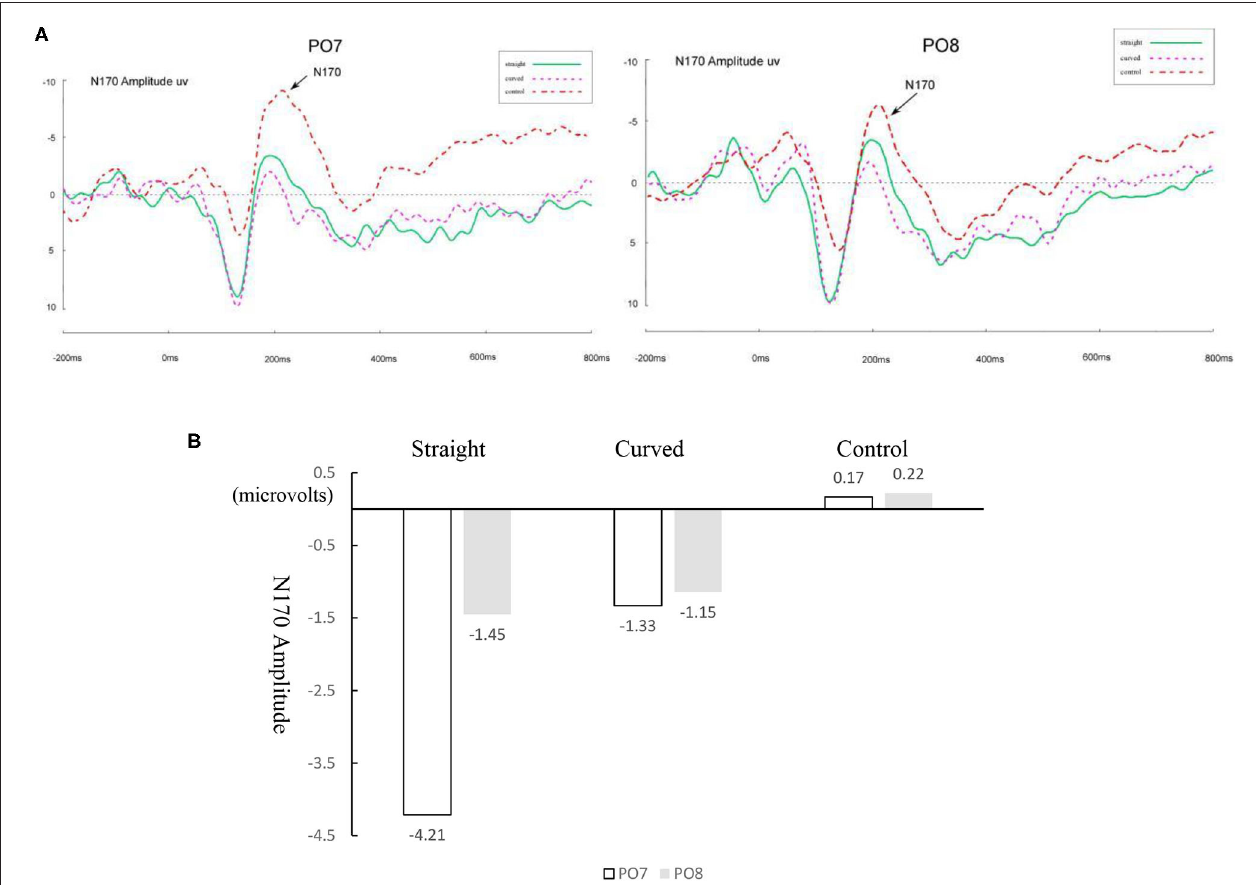
FIGURE 7 | (A) ERP waveforms of N170 under straight, curved control handwriting condition for normal readers for the left (PO7) and right (PO8) parietal leads. (B) Differences between three conditions for normal readers in the amplitude of